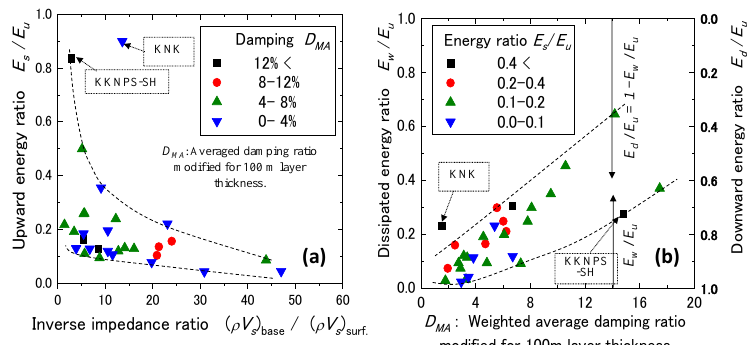
Figure 12. Variations of upward energy E u along depth calculated for nine earthquakes at 30 vertical array sites.